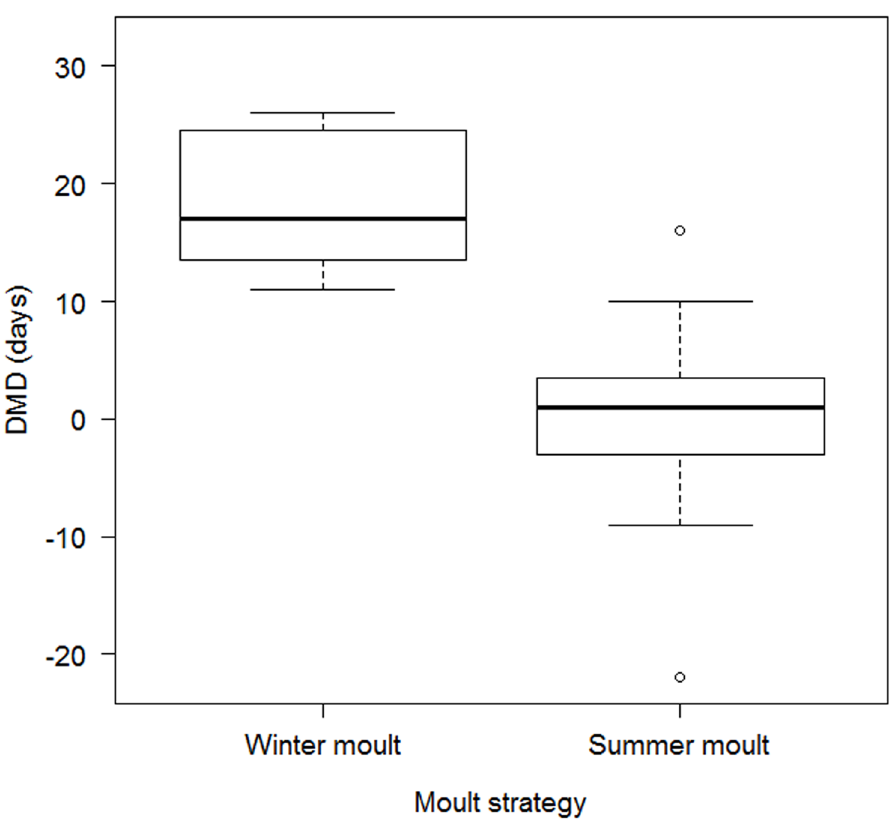
Fig 3. The difference in median migration date (DMD), through Israel, between juveniles and adults (days) in winter moulters (n = 8 species) and summer moulters (n = 15 species). The difference between the two groups was significant) Mann-Whitney U-Test, U = 3.00, Z = 3.69, P < 0.001).